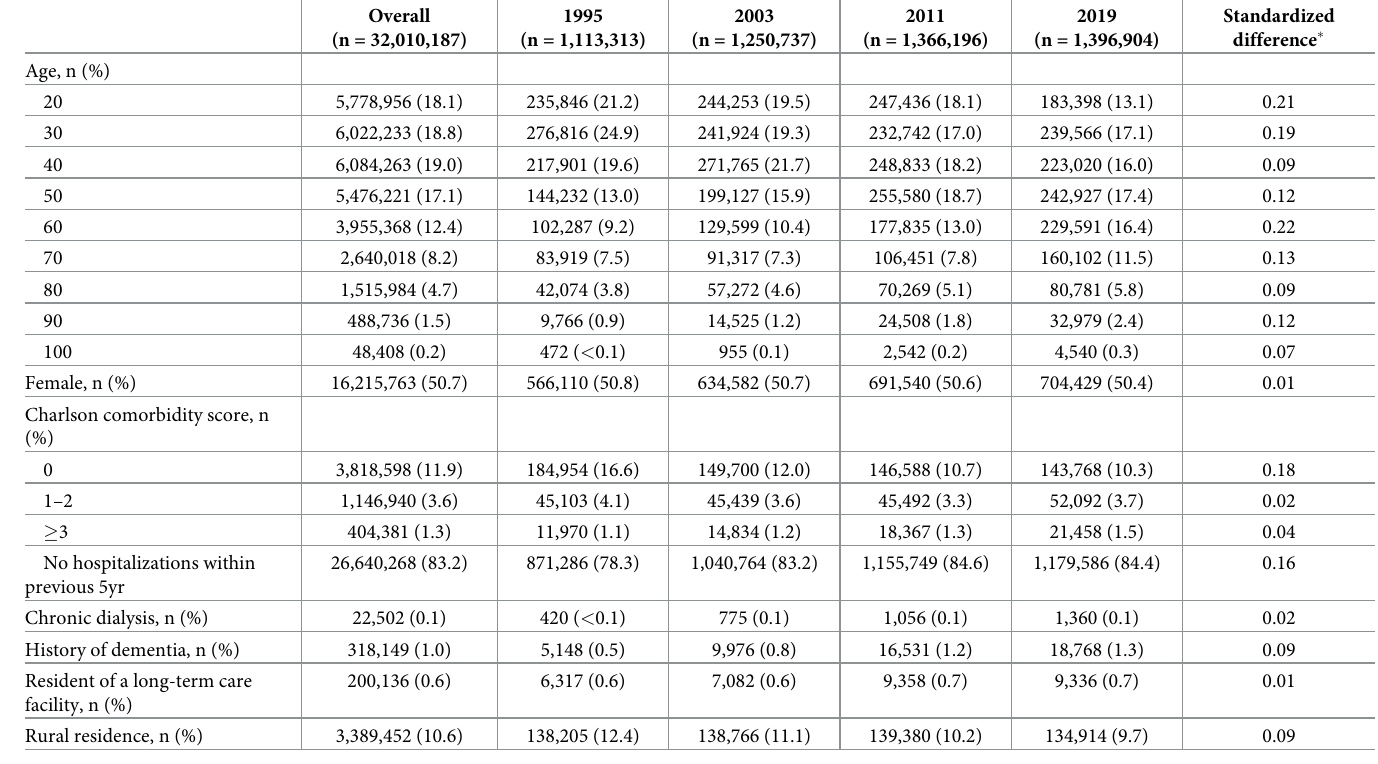
Table 1. Population baseline